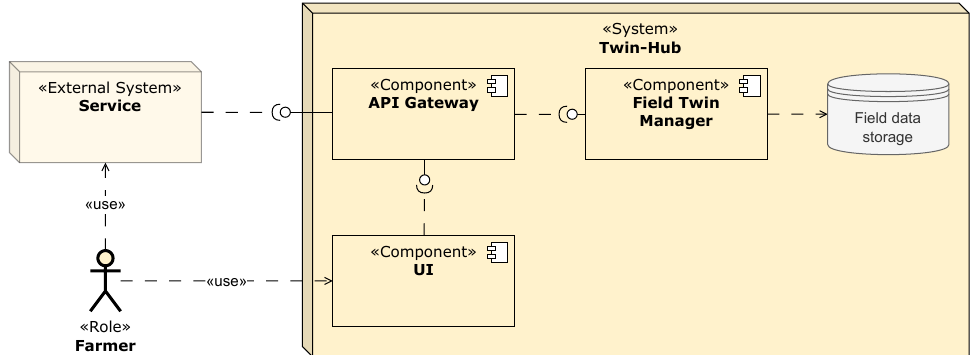
Figure 4. Initial functional decomposition of the